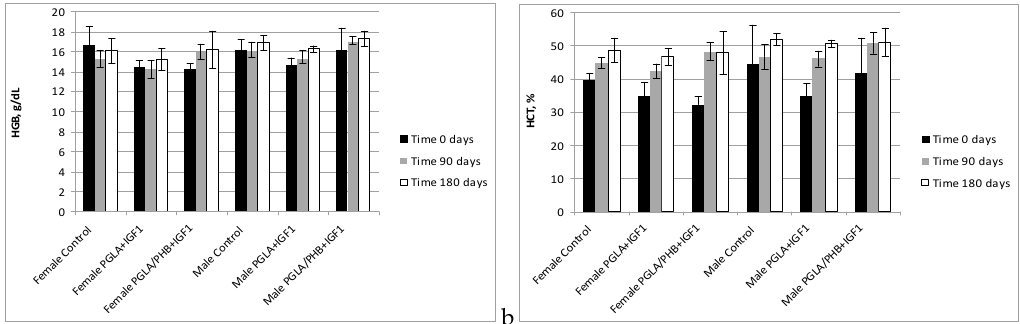
Figure 5. Red cell count (RBC) ( a ) and platelet cell count (PLT) ( b ) in blood of rabbits.